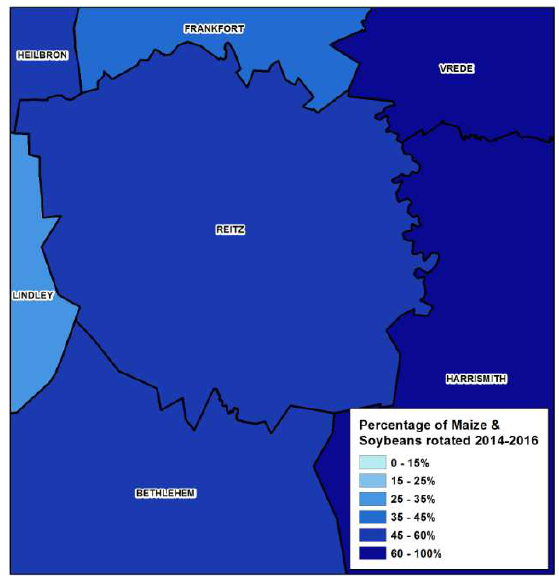
Figure 25. The percentage of area of maize and soybeans rotated for the Reitz and surrounding districts between 2014 and 2016